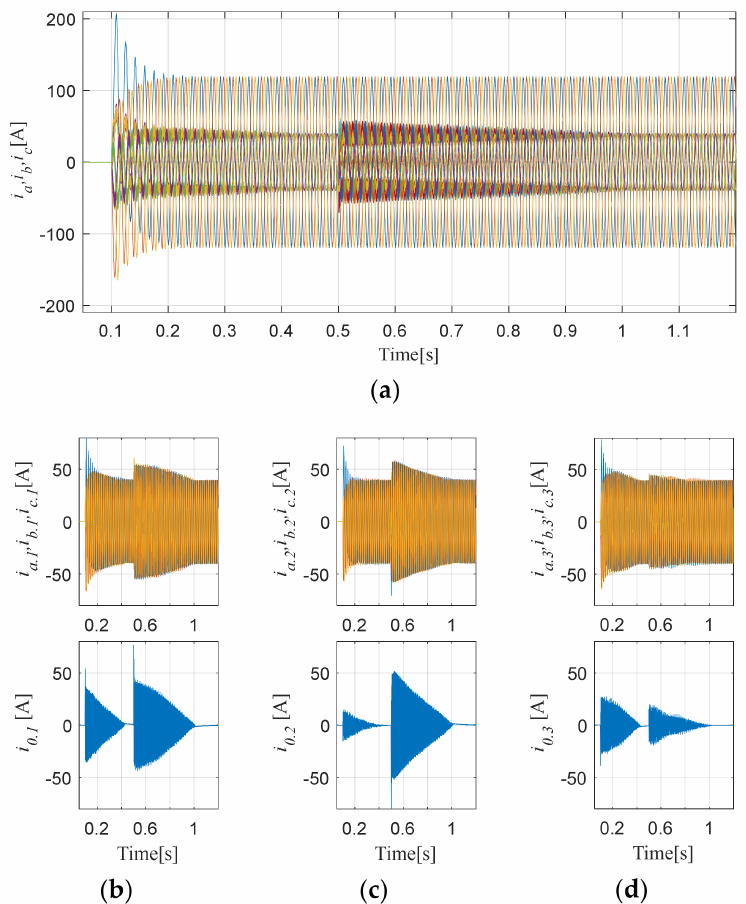
Figure 9. Results of simulation of control for phase errors occurring during normal operation 1 ( a ) Total inverter output current and the output current of each inverter, ( b ) output current and zero − sequence current of inverter 1, ( c ) output current and zero − sequence current of inverter 2, ( d ) output current and zero − sequence current of inverter